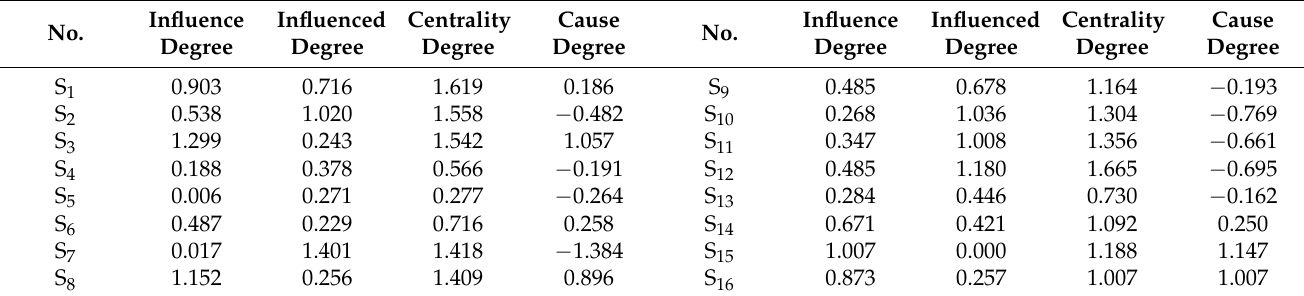
Table 5. Influence degree, influenced degree, centrality degree, and cause degree of each causative factor.